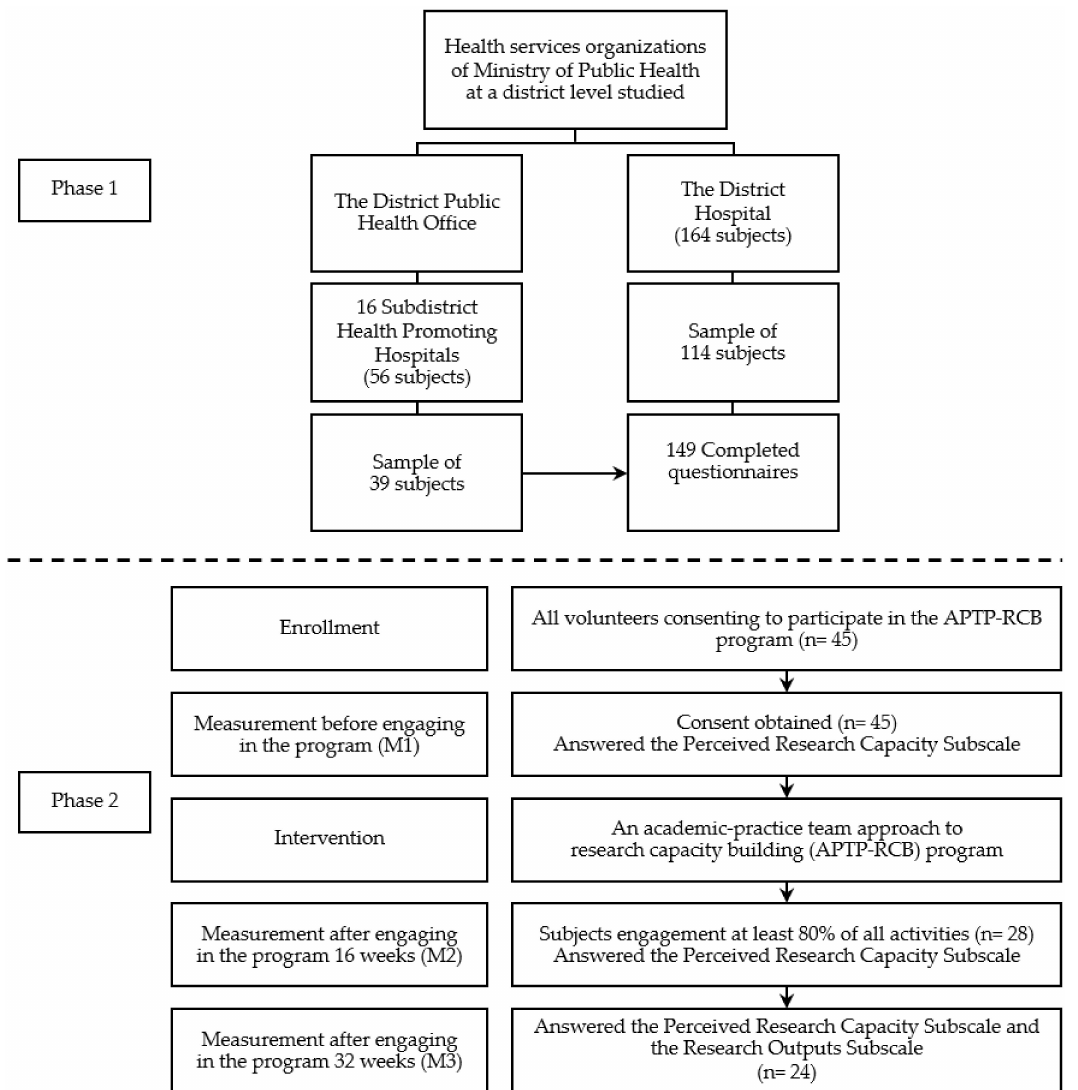
Figure 1. Flow diagram of participants and data collection in phase 1 and 2